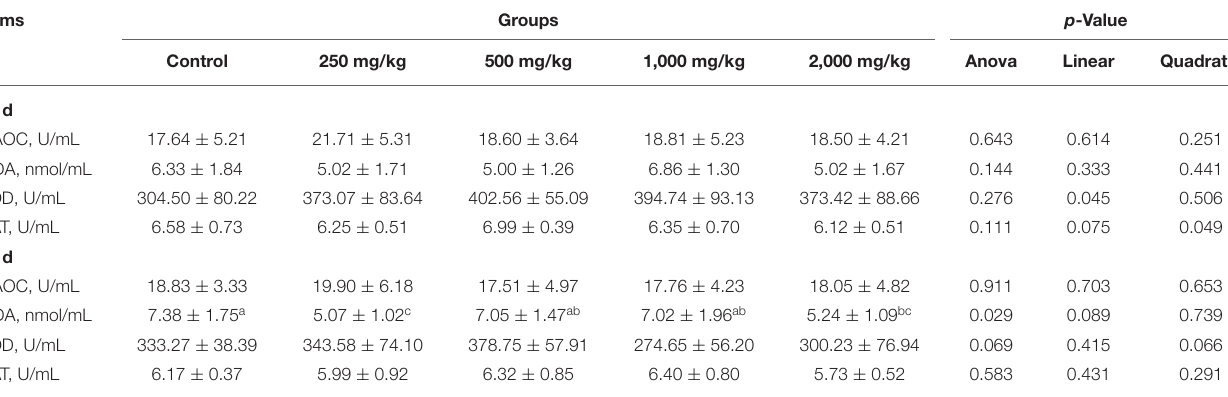
TABLE 5 | Effect of dietary Galla chinensis extract (GCE) supplementation at different levels on serum antioxidation of broilers. Items Groups p